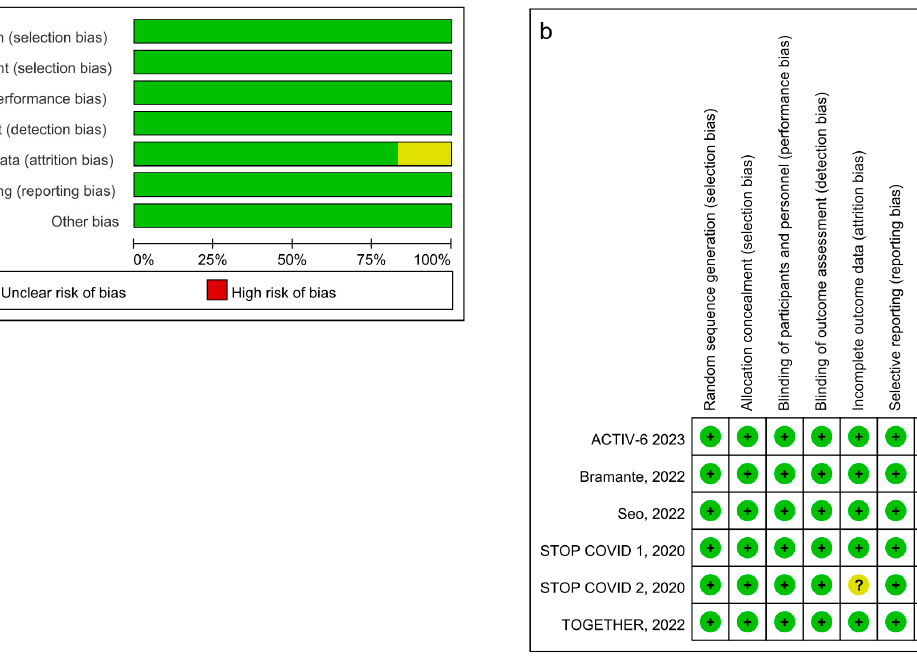
Figure 2. ( a ). Risk of bias graph across the included studies. ( b ). Summary of risk of bias of the included studies ([6–8,16–18]). Table 1. Demographic data of the included